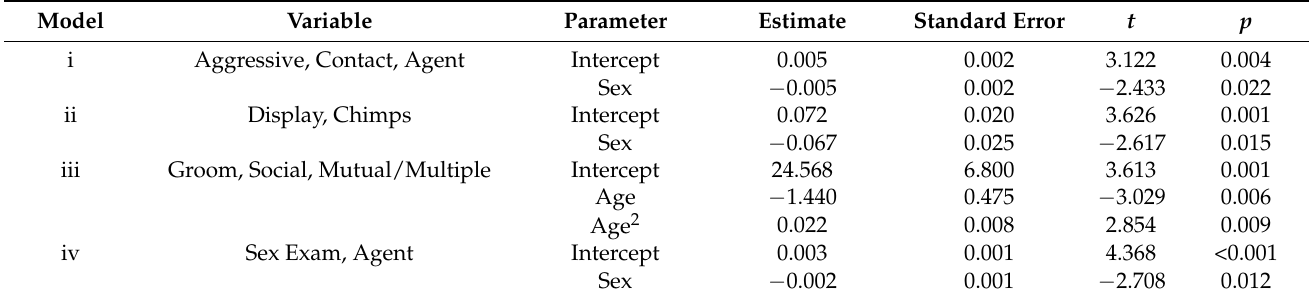
Table 2. Model estimates for predicting behaviors with significant variables. Linear regression models (training dataset) included the explanatory variables found to be significant predictors. Possible fixed factors included: sex, age, and age 2 .